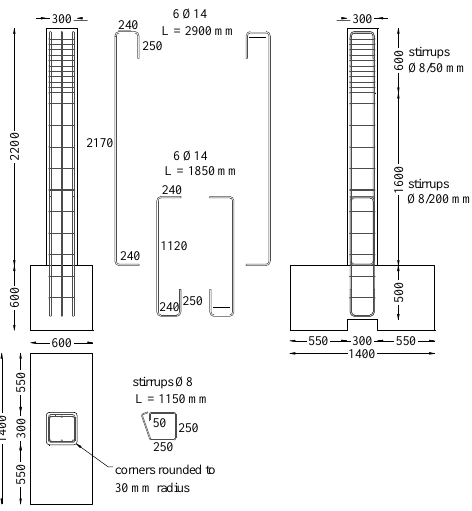
Figure 1. Details of RC